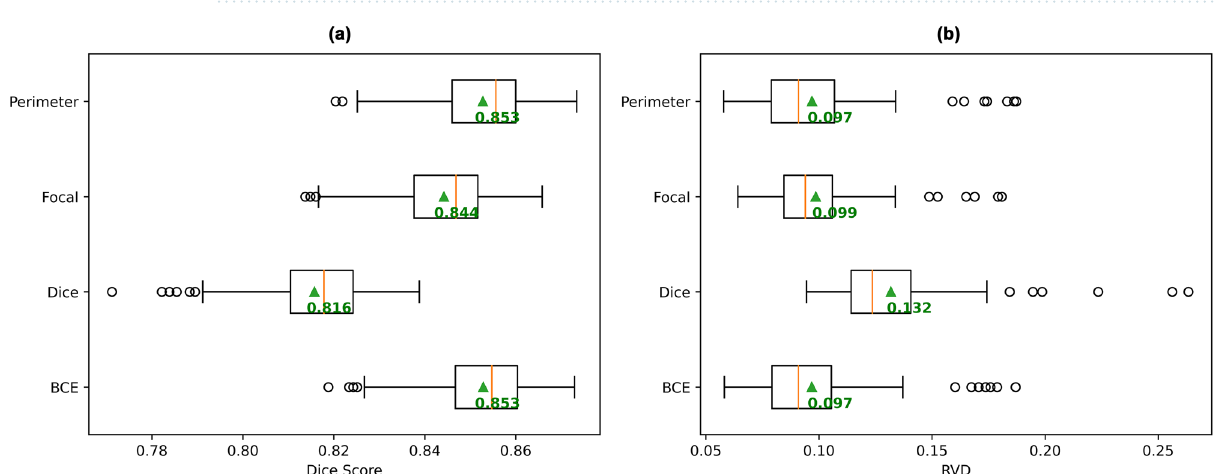
Figure 2. Comparison of performance of six different models. Box plots of ( a ) the mean Dice scores for all subjects (higher is better), and ( b ) the mean RVD values for all subjects (lower is better). Mean across all subject scores is indicated by green triangle and text. Orange bar indicates median score. Models with the highest mean Dice score and lowest RVD value are bolded.